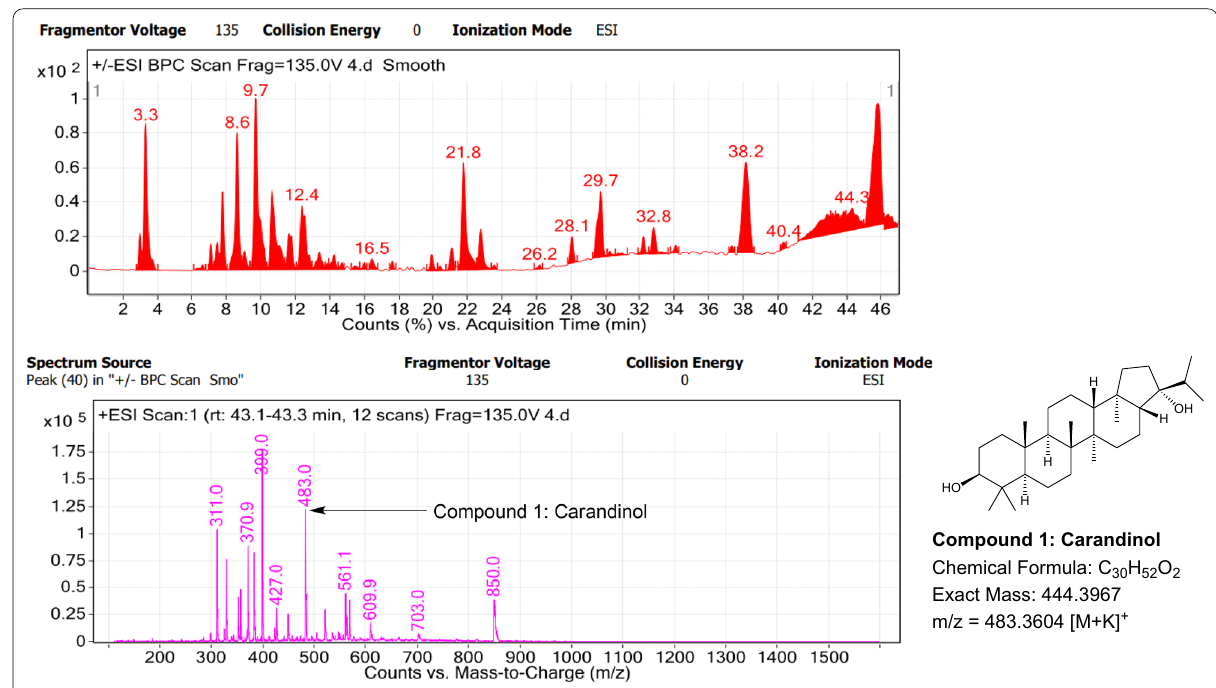
Fig. 10 LC–MS chromatogram of root extract of Carissa carandas showing marker compounds